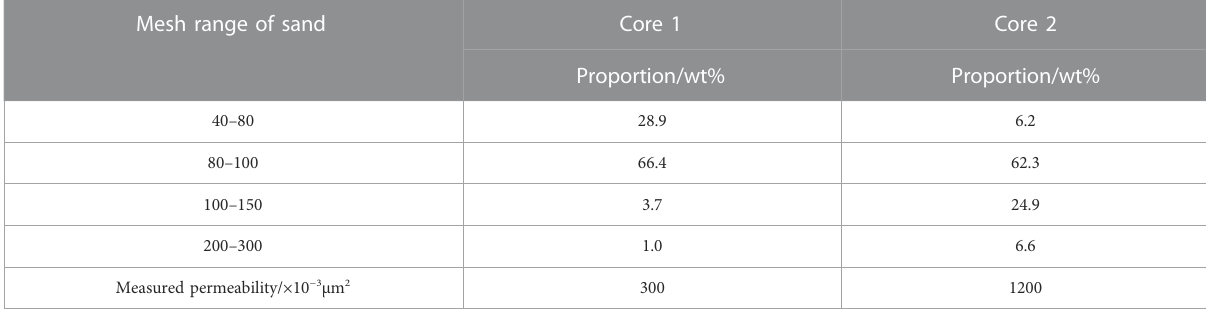
TABLE 3 Sand formula used to fabricate different permeabilities for 3D cores (measured from 1D cores). Mesh range of